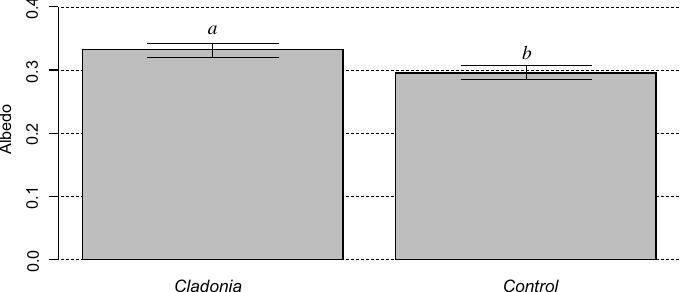
Supplementary Figure 3. Albedo of the five control modules and five Cladonia modules recorded on September 28,